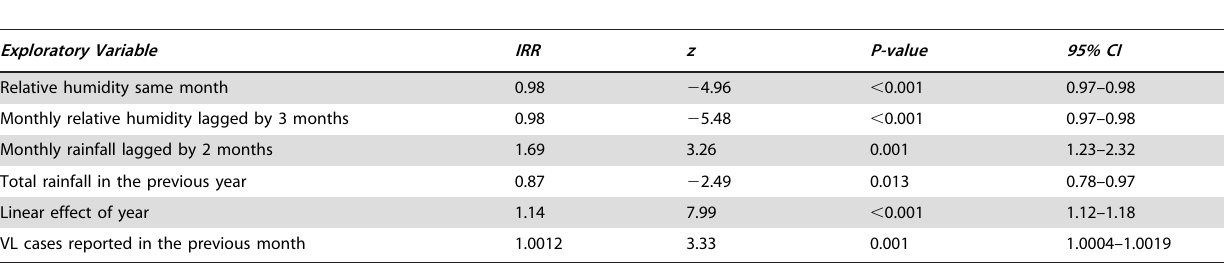
Table 1. Final negative binomial model for monthly count of reported Visceral Leishmaniaisis (VL) cases in Muzaffarpur district from 2000 to